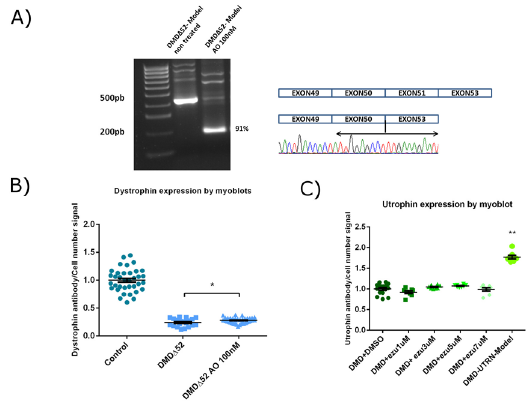
Figure 4. Evaluation of potential therapies in the generated cell culture models. ( A ) DMD∆52-Model cell line was treated with an antisense to skip exon 51 and the effect was evaluated by RT-PCR and nested PCR analysis. Gel picture shows a pattern corresponding with the correct skipping, which was confirmed by Sanger sequencing. The same experiment evaluated by myoblot using n = 20 replicate wells per condition ( B ) showed the restoration of dystrophin expression in the treated cultures compared to non-treated (* p values < 0.05. p values were determined with Mann–Whitney U test). ( C ) The DMD-UTRN-Model was used as a positive control in an experiment in which unedited DMD cultures were treated with different ezutromid concentrations to up-regulate utrophin expression. Myoblot analysis using n = 8 replicate wells per condition of the treated cultures shows that ezutromid had no significant effect in DMD cultures while utrophin expression is significantly increased in DMD-UTRN-Model compared to unedited DMD cultures. (** p values < 0.01. P values were determined with Mann–Whitney U test and error bars represent mean ± SEM).